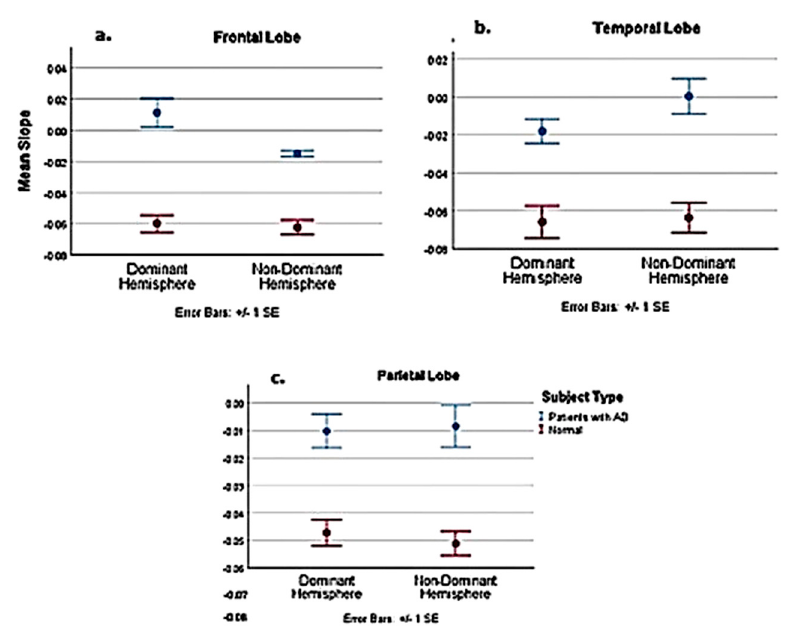
Figure A3. Slope comparison between pooled normal 3 age groups and AD subjects.